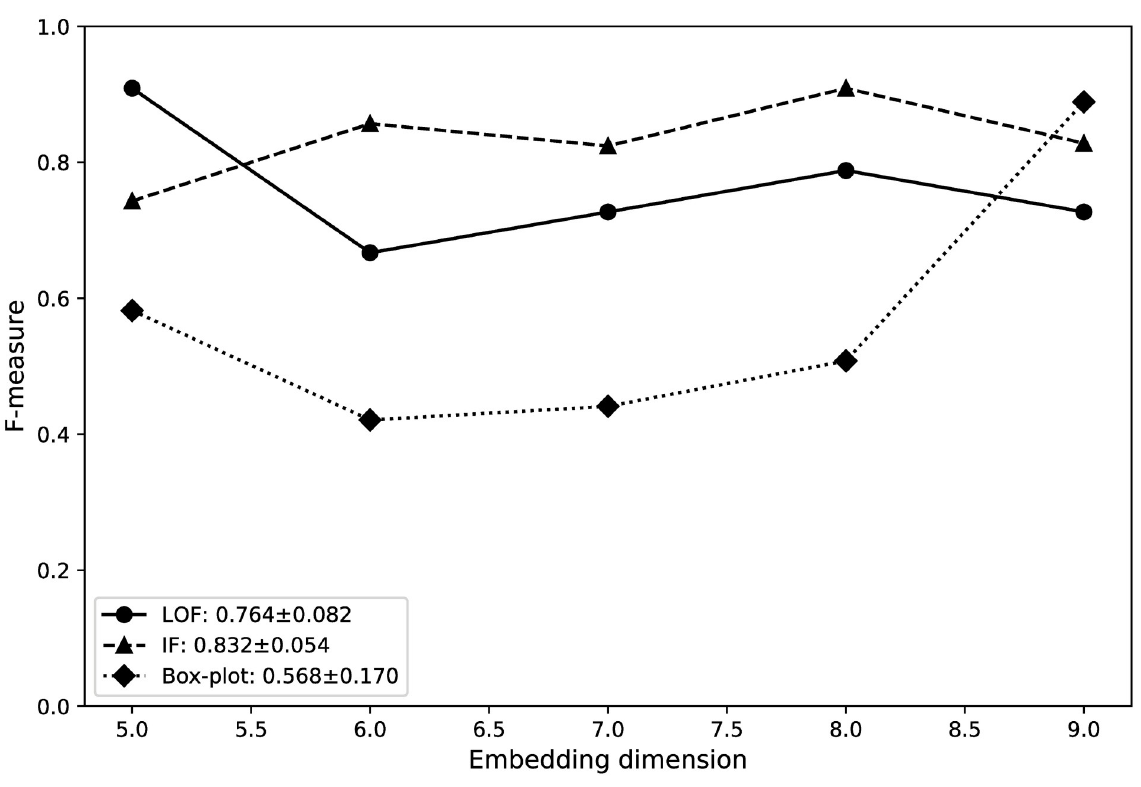
Fig 6. Evaluation of